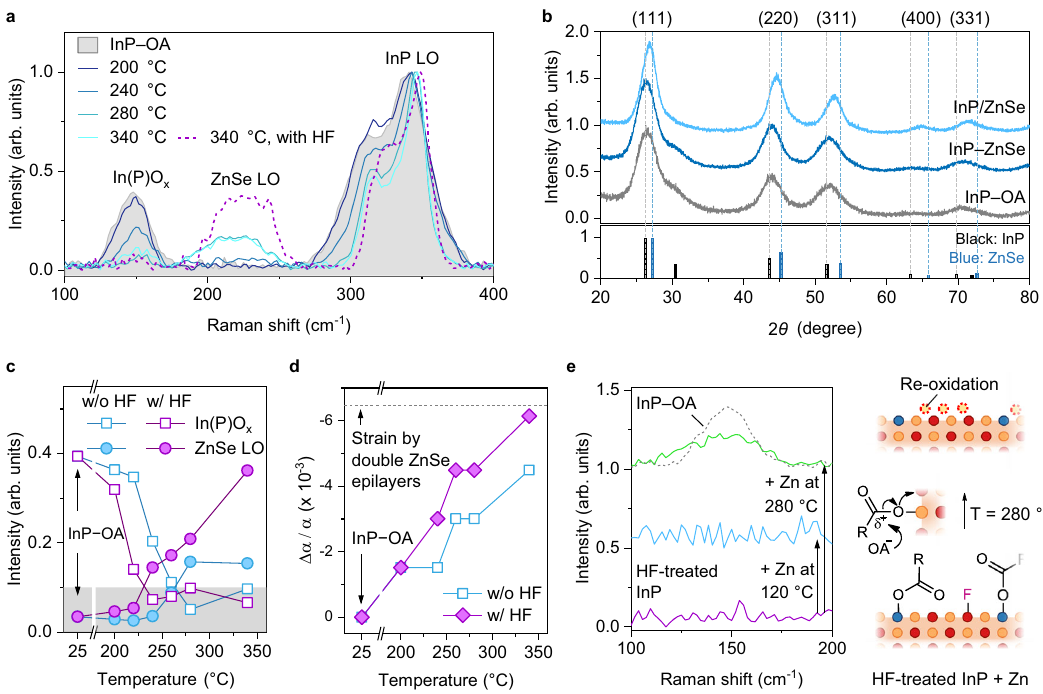
Fig.3|TransformationofZnandSeadatomstocrystallineZnSeepitaxiallayer. a Raman spectra of InP – OA NCs with a size of 3.3nm (grey) and InP – ZnSe NCs annealed atelevated temperatures of 200(deep blue),240(blue),280(lightblue), and 340°C (cyan). InP – ZnSe prepared in the presence of HF (purple dotted line) resulted in a stronger ZnSe LO mode. b X-ray diffractograms of InP – OA (grey), InP – ZnSe (blue), and InP/ZnSe (light blue; annealed at 340°C). For comparison, diffraction lines of bulk InP (black) and ZnSe (blue) are included at the bottom. c Intensities of In(P)O x (open square) and ZnSe LO phonon modes (solid circle) at different reaction temperatures without (light blue) and with HF (purple). Grey background represents the noise level. d Hydrostatic strain ( Δ α / α ) applied to InP